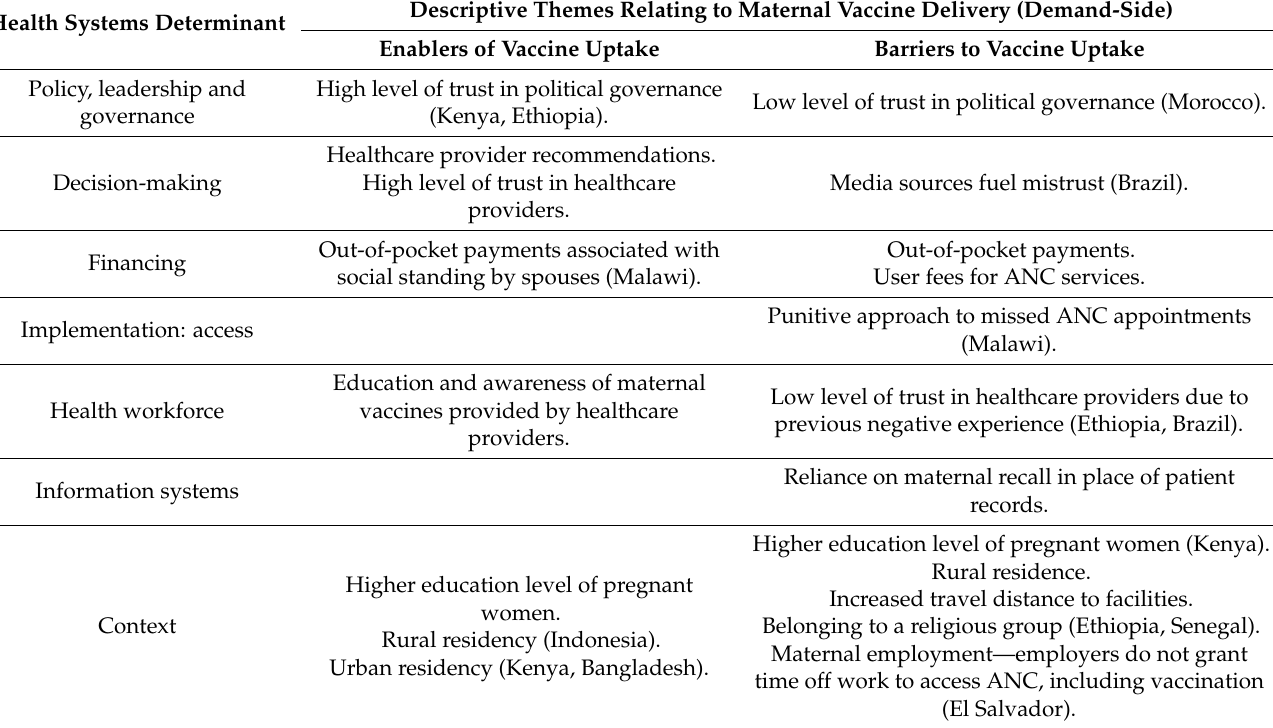
Table 3. Descriptive themes on health systems determinants of uptake of maternal vaccines in